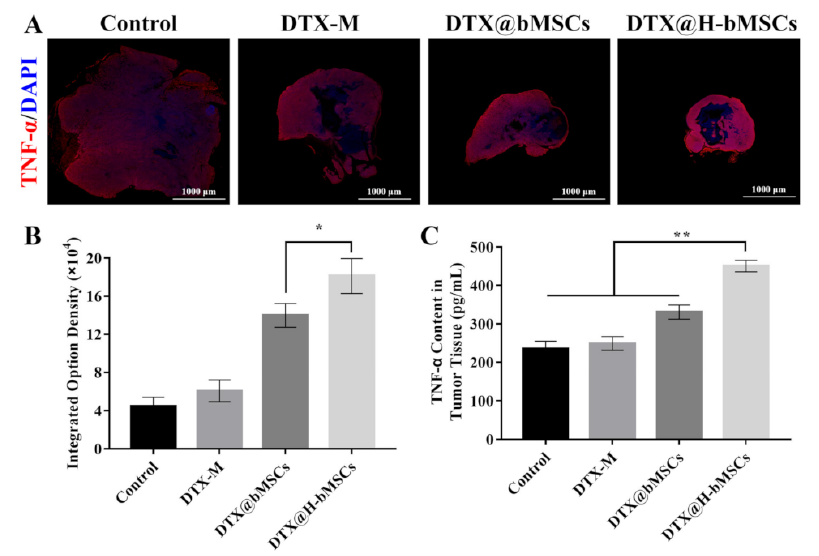
Figure 10. Representative immune-fluorescence imaging ( A ) and IOD analysis ( B ); TNF- α levels in tumor tissue measured by quantitative ELISA ( C ). Red fluorescence indicates TNF- α and blue indicates DAPI. (* p < 0.05) (** p <